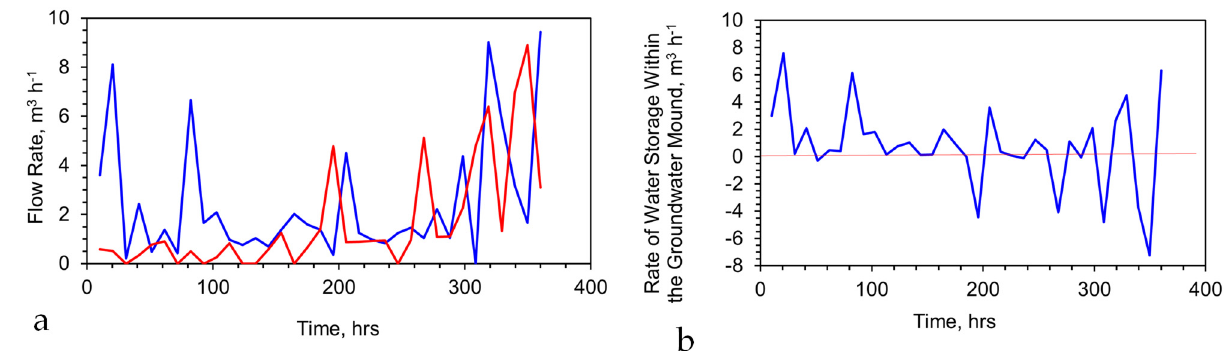
Figure A26. Observed operation of a groundwater mound located in boulder clay (Scotland, UK). ( a ), Flow rate versus time. Red = abstraction; blue = recharge; ( b ) rate of storage into the groundwater mound. Positive values indicate that the recharge exceeds abstraction; negative values indicate that the abstraction exceeds the recharge and that relict/retained water is being included in the abstracted water flows.